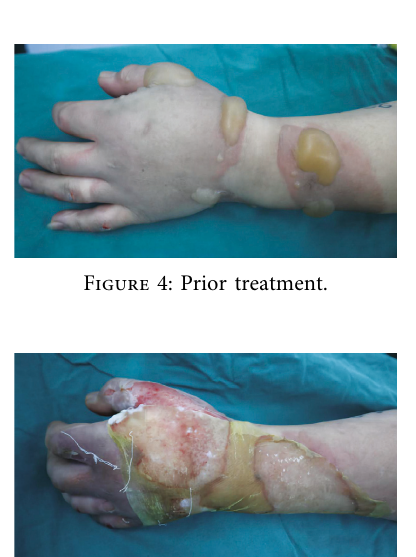
Figure 3: 7d after treatment.